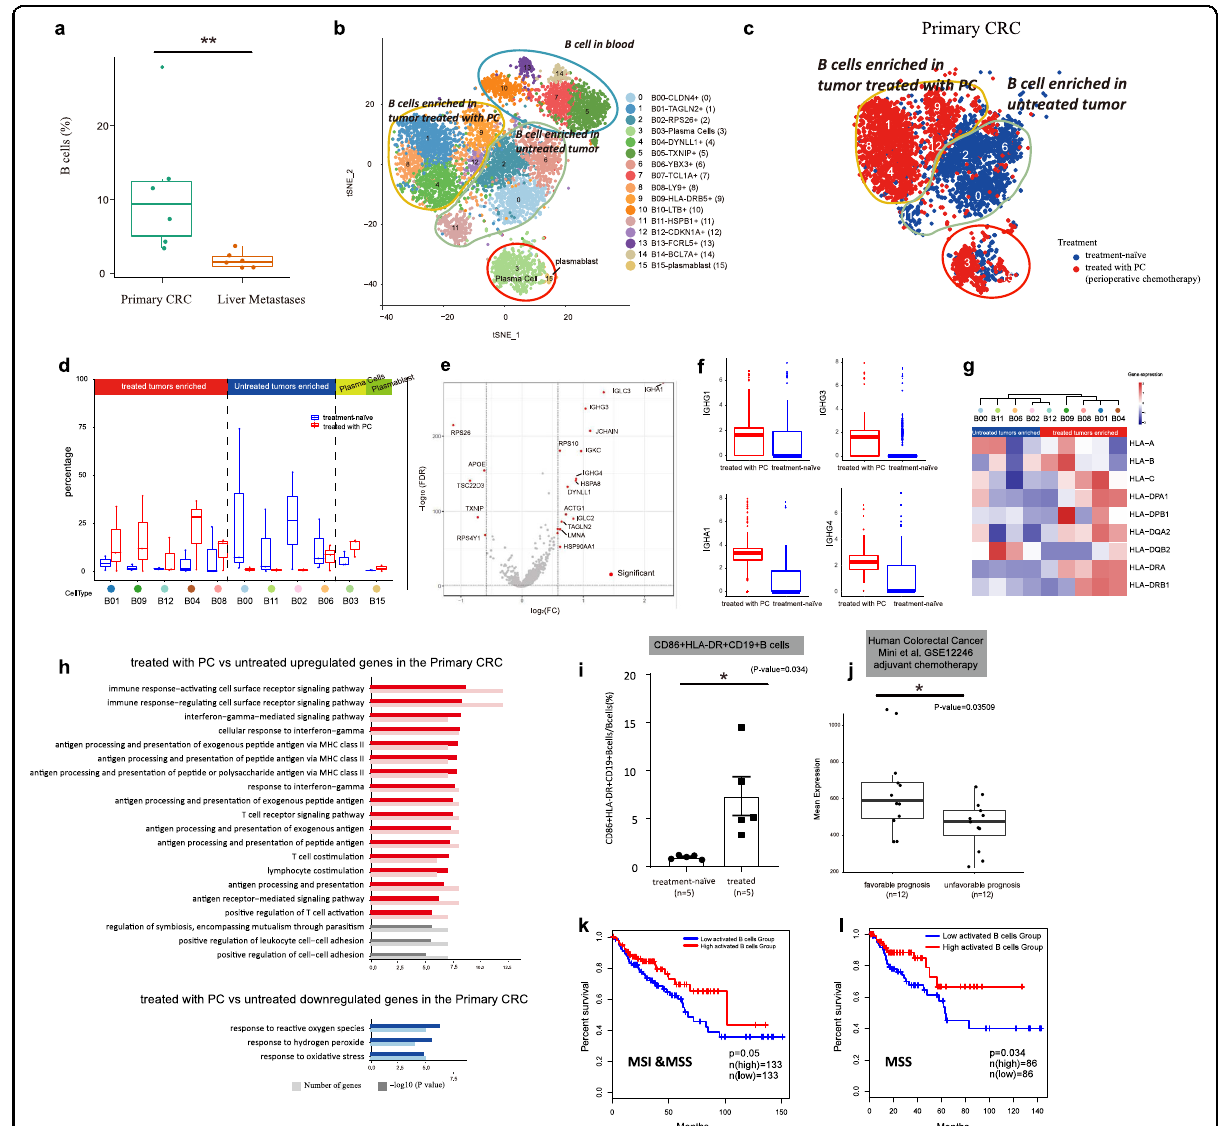
Fig. 2 scRNA-seq of B cells reveals distinct subpopulation composition in tumors treated with PC or treatment-naïve. a Boxplot comparing the frequency of B cells between the primary CRC and liver metastases. Each dot represents the percentage of B cells from one sample. P value was calculated using Wilcoxon rank-sum test, ** P < 0.01. b t-SNE plot of scRNA-seq pro fi le from 7454 B cells separated into 16 subtypes. Cells are colored according to different cell types. c t-SNE plot of scRNA-seq pro fi les of B cells in the primary CRC. Cells are colored according to treatment status (treated with PC or without PC). d Boxplots showing the percentage of each B cell subcluster in untreated and treated samples in the primary CRC. The plot shows that B01, B04, B08, B09, and B12 are enriched in tumors treated with PC, whereas B00, B11, B02, and B06 are prevalent in untreated tumors. e Volcano plot showing DEGs between B cells enriched in tumors treated with PC and B cells prevalent in untreated tumors. Each red dot denotes an individual gene with adjusted P value < 0.05 and fold change ≥ 1.5 (two-sided moderated t -test with limma). f Box plots showing the expression of IGHG1, IGHG3, IGHG4, and IGHA1 in PC-treated and treatment-naïve tumors. g Heat map showing the relative expression of MHC molecules in each B cell subtype. h GO analysis for upregulated genes (top) and downregulated genes (bottom) with P < 0.05 in tumors treated with PC vs without PC. Pathways related to immune activation are colored by red; pathways related to in fl ammation are colored by blue. i The FACS results showing the abundance of activated B (CD86 + HLA-DR + CD19 + ) cells in CRC patients treated with or without PC. j Boxplot showing the levels of the B cell signature in samples from pretreated colorectal cancer patients in the dataset GSE12246, adjuvant chemotherapy 86 . k The Kaplan – Meier overall survival curves of TCGA COAD patients grouped by different expression levels of signature genes of activated B cells enriched in PC-treated tumors. Patients involved in this analysis include MSI-high, MSI-low, and MSS patients. Patients separated by high- ( n = 133) or low-level ( n = 133) B cell gene signature exhibit different overall survival ( P = 0.05). l Overall survival curves of TCGA COAD patients. Only MSS patients were involved in the analysis. P =